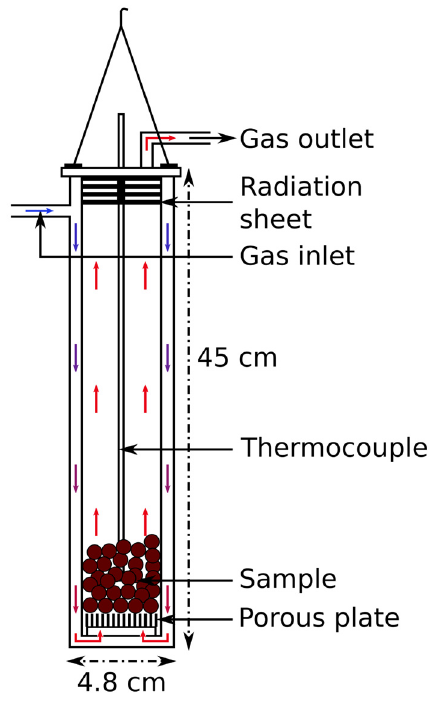
Figure 1. X-ray diffraction patterns for the pre-oxidized ilmenite pellets. The measured data are given as black dots and the fitted data are given as a red line. The difference between the fit and the measured pattern is plotted below the pattern. The estimate of each phase in wt.% based on Rietveld fitting is given in the legend, the balance being quartz.